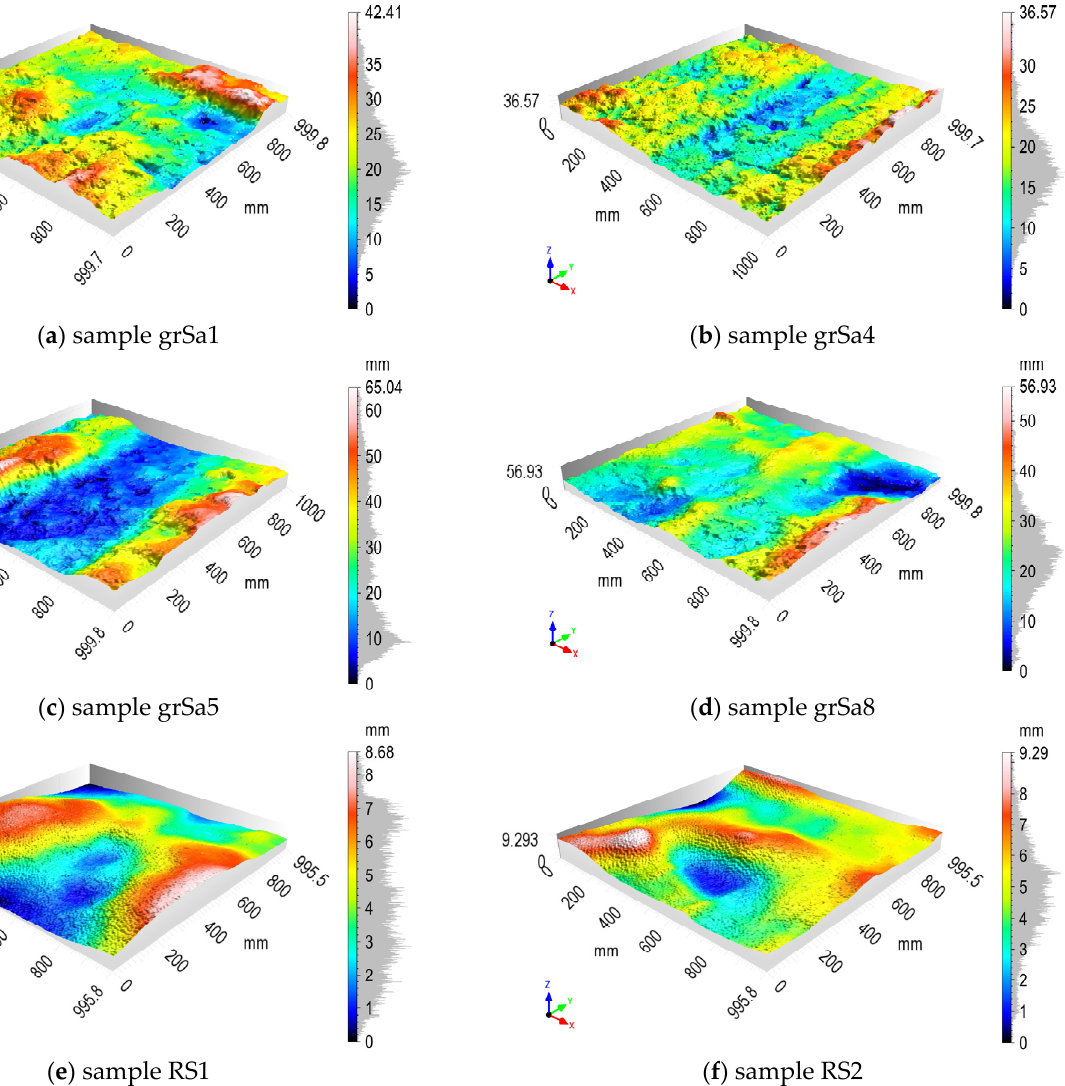
Figure 13. Results of surface processing for chosen samples: ( a – d ) diaphragm wall from sandy gravel; ( e , f ) reference surface.